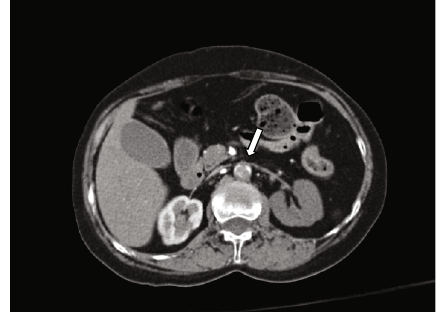
Figure 1: CT angiogram demonstrating AAO (arrow) with hypoperfusion of the left